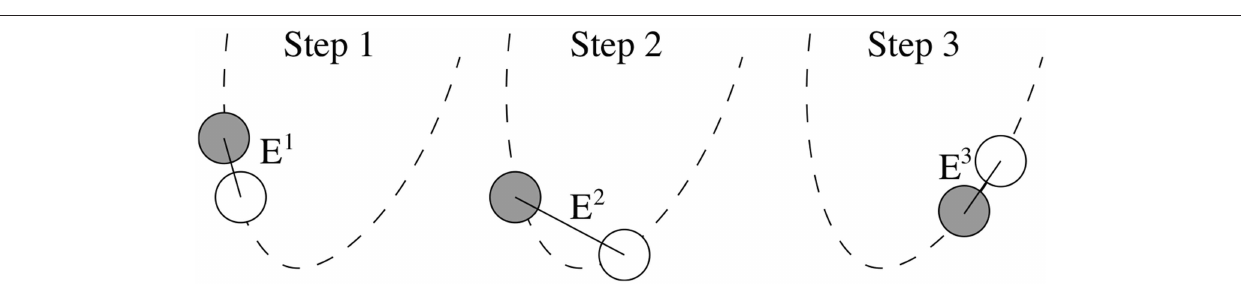
FIGURE 4 | Error (magnitude of black line) across three different timesteps when particle drift is out of phase. Particle trajectory is denoted by the dashed arc, the approximated free-body is denoted by the gray circle, and the exact free body is denoted by white circle.